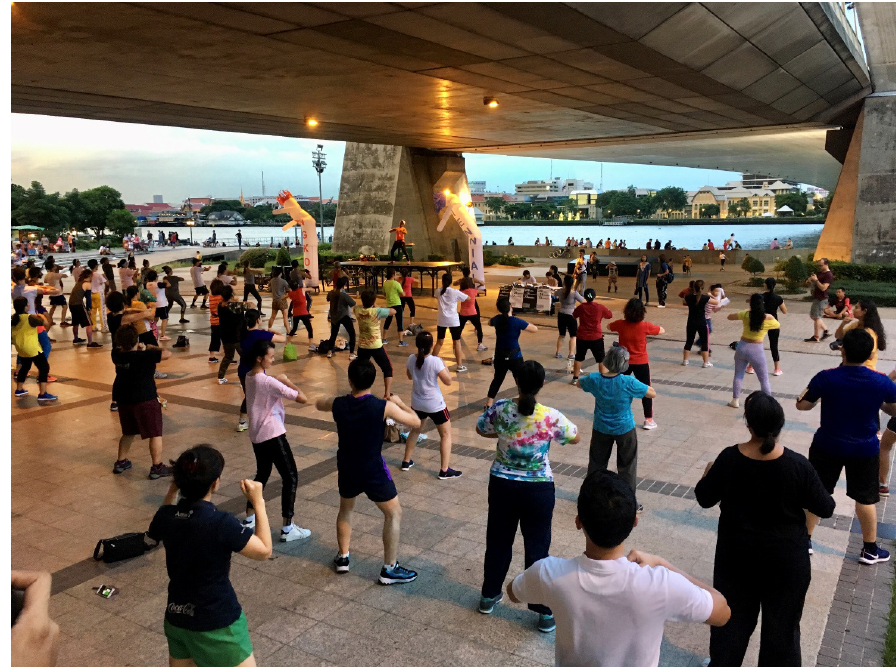
Figure 1. Bangkok Biennial opening ceremony during the daily 6 PM public aerobic session, under the Rama VIII bridge in Bangkok (July 2018). Photo by the